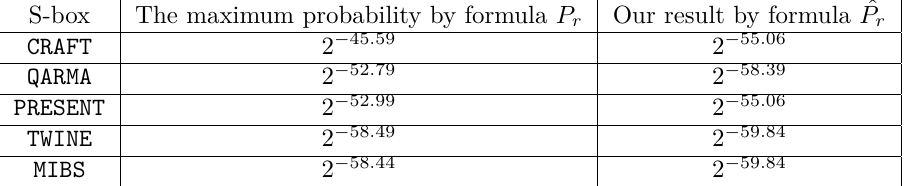
Table 5: The probability of 13-round boomerang distinguishers for different S-boxes